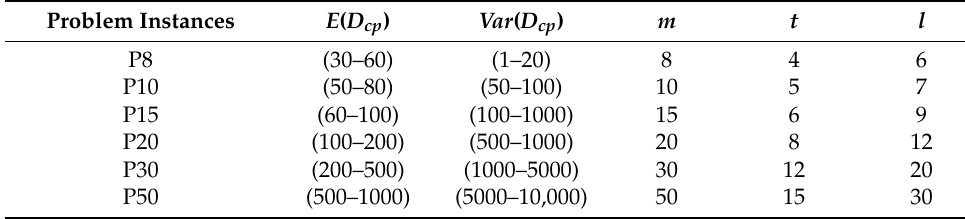
Table 2. The parameters of problem